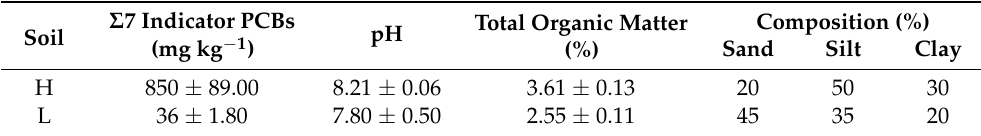
Table 1. Physico-chemical characteristics of PCB-polluted soils.